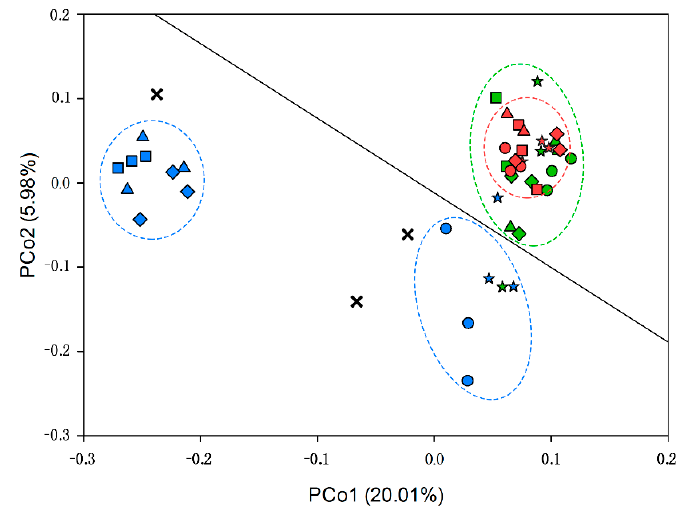
Figure 1. PCoA analysis of Bray ‐ Curtis distance between samples. The points can be distinguished by color (management) and shape (plant types). Red indicated management group N; green represented group I; and blue indicated group O. Control group was indicated by black cross ”X”. Five ‐ pointed star represented native plants; circular represented Soybean ‐ Maize; square indicated Soybean ‐ Elymus; triangle indicated Alfalfa ‐ Maize; and diamond represented Alfalfa ‐ Elymus. The black solid line, which divide the image into two parts, presented the fertilization status. The upper part of the black line indicated that no fertilizer was applied. In contrast, the lower part showed the application of fertilizer. According to the redundancy analysis (RDA) (Figure 2), the proportion explaining RDA1 was 21.97%; this proportion was greater than that for RDA2, which was 10.26%. On the RDA axes, the relationships between environmental variables and the axes were determined by projection length on the RDA axis (arrow length and angle size).